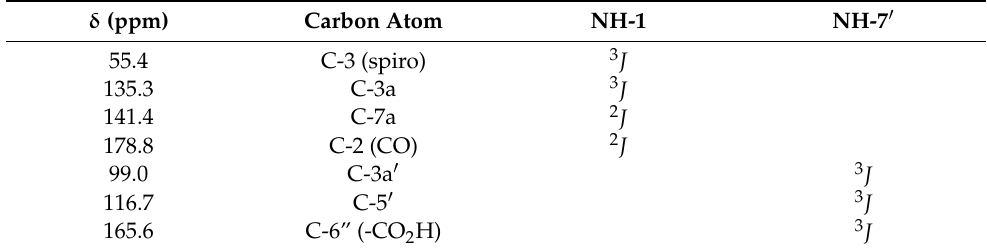
Table 2. C-H correlation with NH-1 and NH-7 (cid:48) protons observed in the HMBC